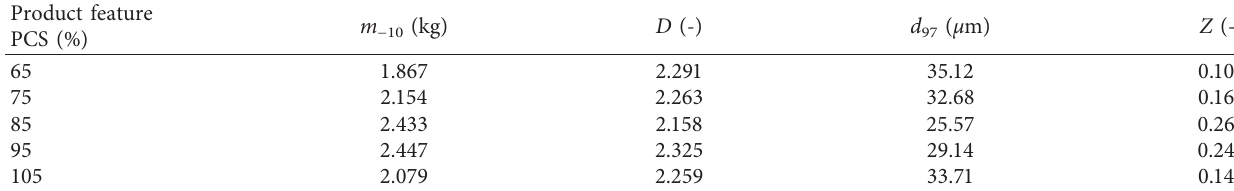
Table 1: Variation of product feature at different speeds.